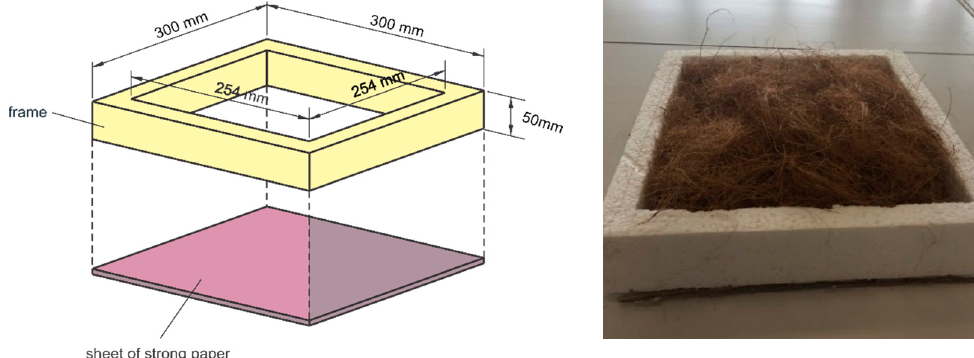
Figure 3. Specimen holder.